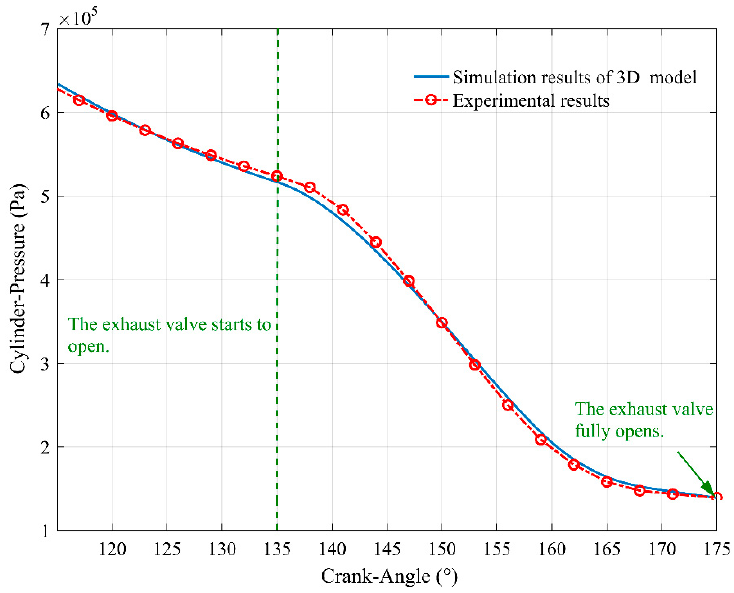
Figure 8. Comparison chart of the in-cylinder pressure.